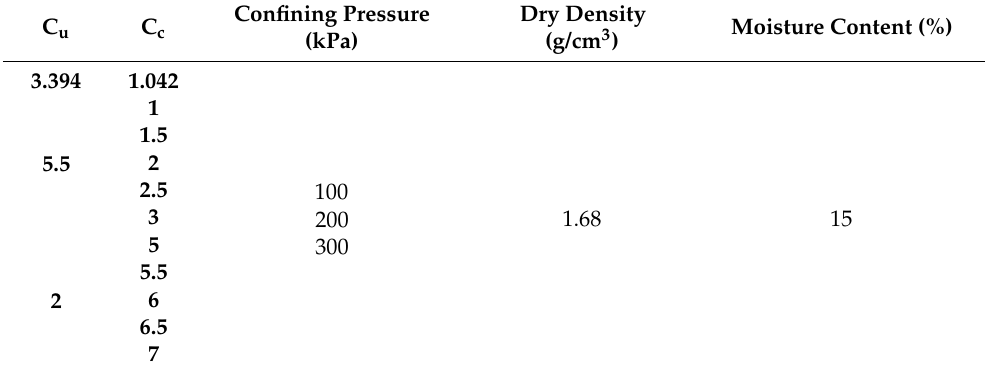
Table 4. Parameters before the grading